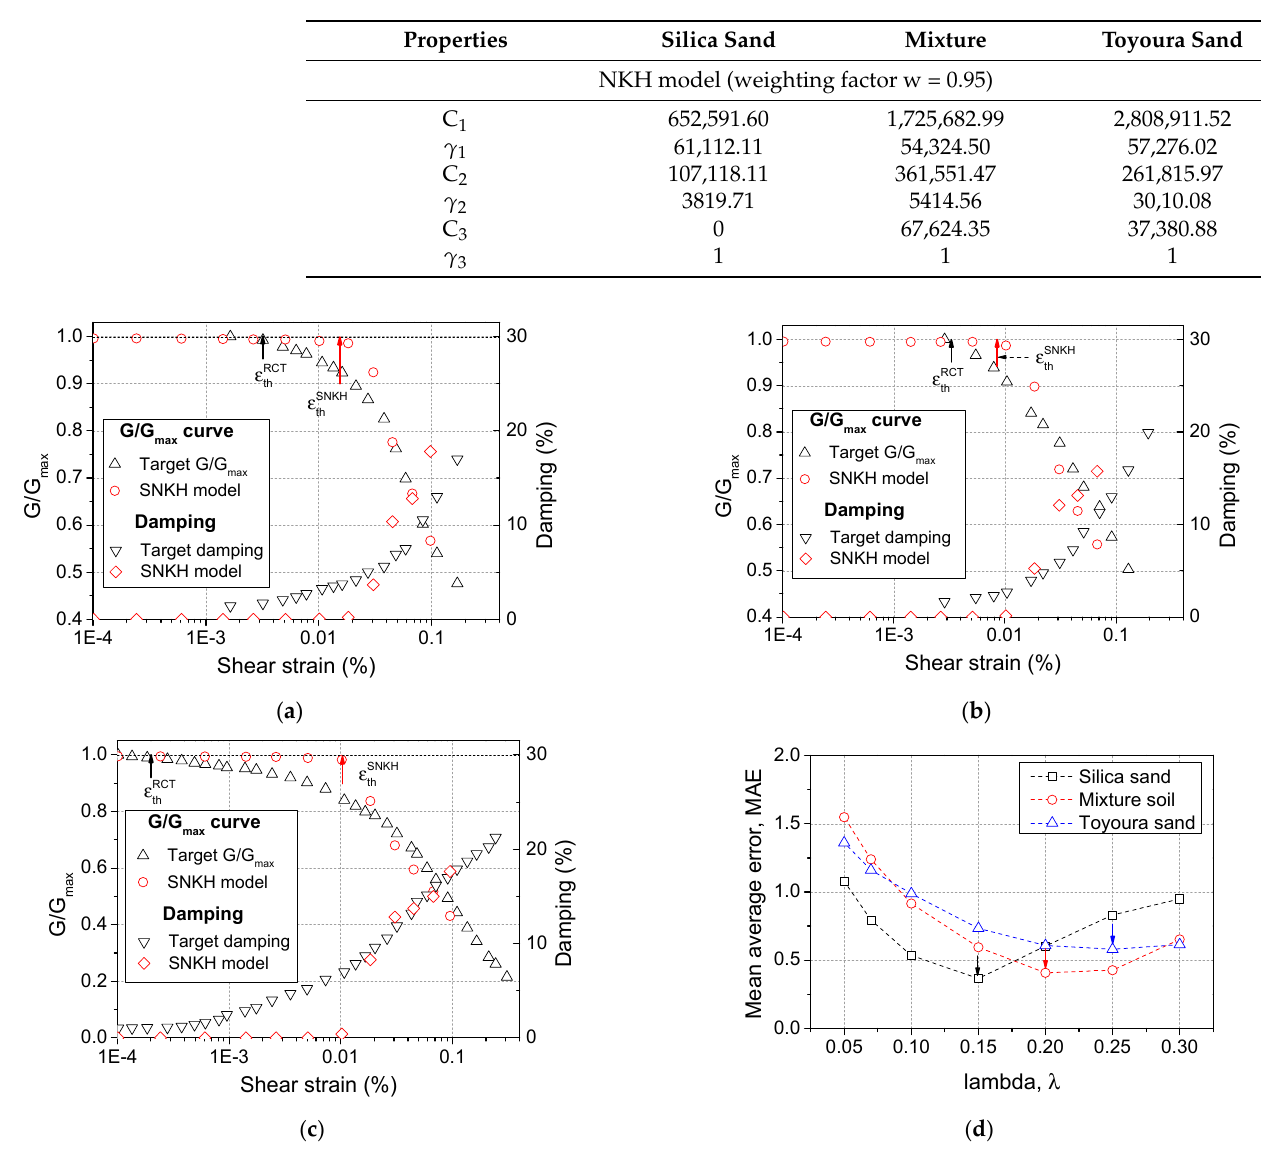
Figure 1. G/G max and damping curve obtained from RCTs and the SNKH model for ( a ) silica sand; ( b ) mixture soil; and ( c ) Toyoura sand; and ( d ) MAE value for three soils. The arrows show threshold strain in ( a – c ), and the lowest lambda value in ( d ). Table 1. Soil properties and parameters of SNKH and NKH models.